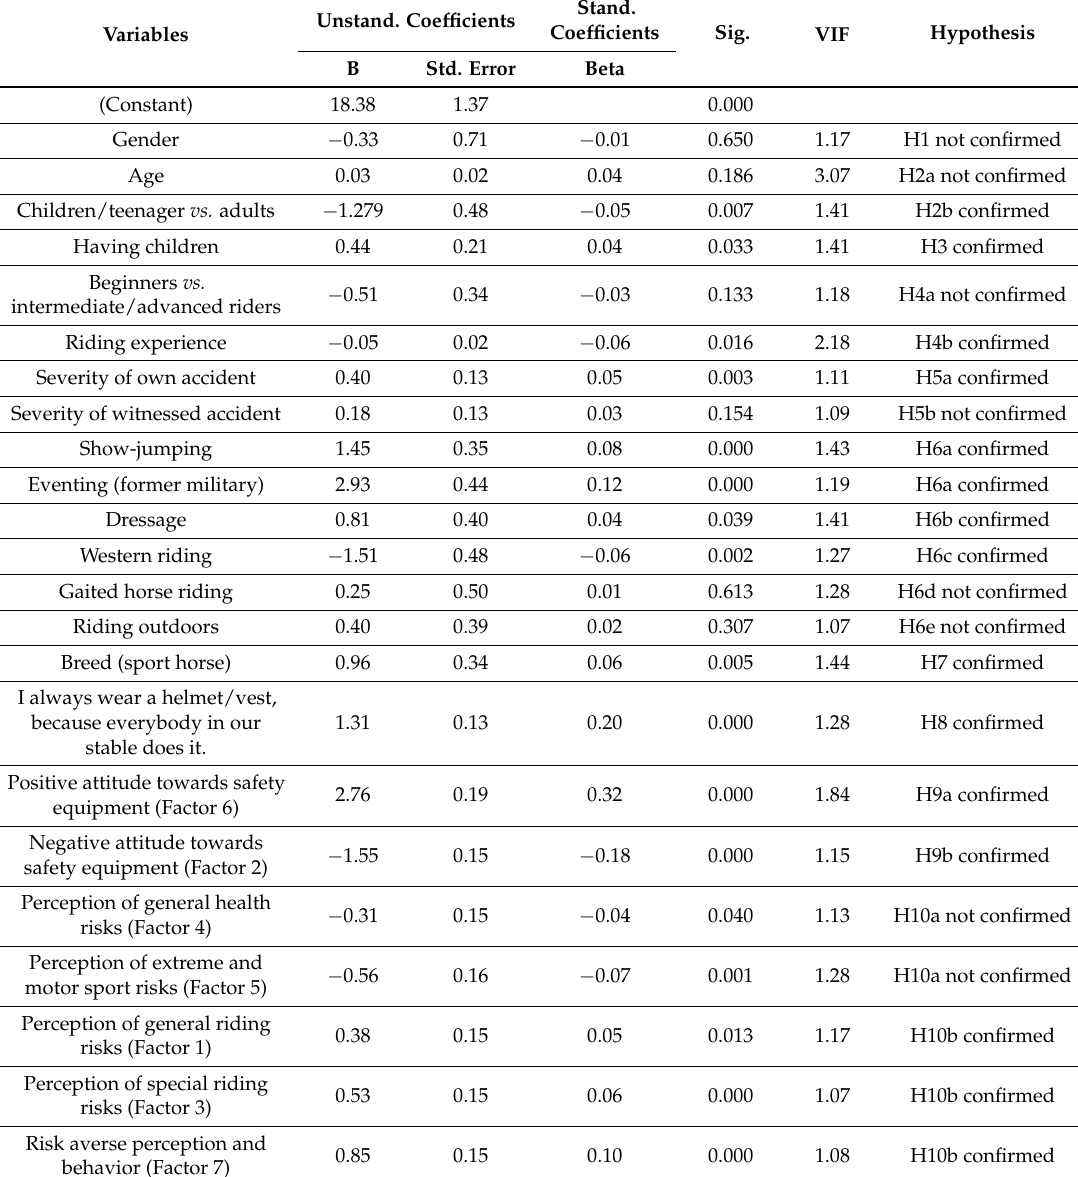
Table 6. Results of the multiple regression